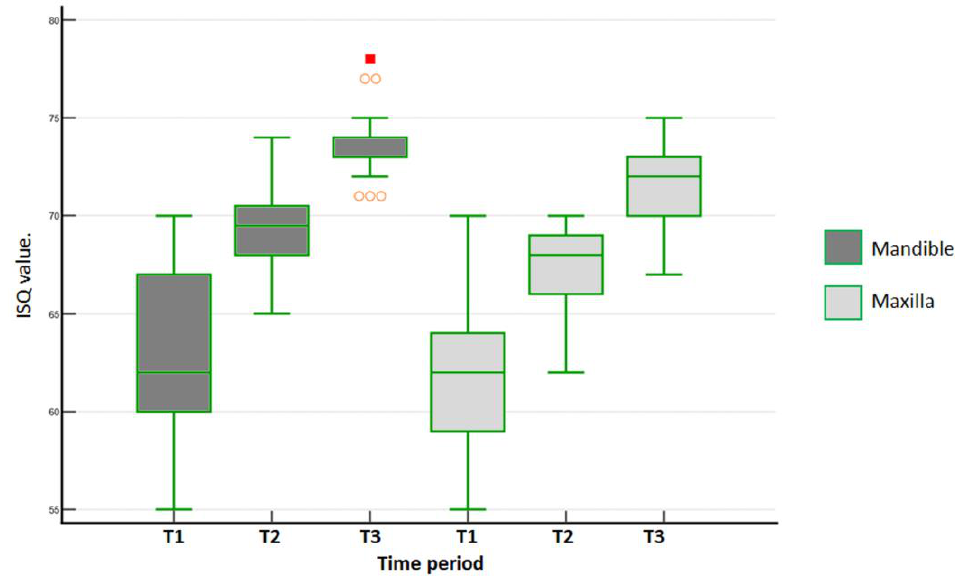
Figure 9. Data distribution of M-D ISQ values measured for MAE group within each arch in each time period (T1 = baseline; T2 = 30 days; and T3 = 45 days). Outlier values are indicated in orange and red.